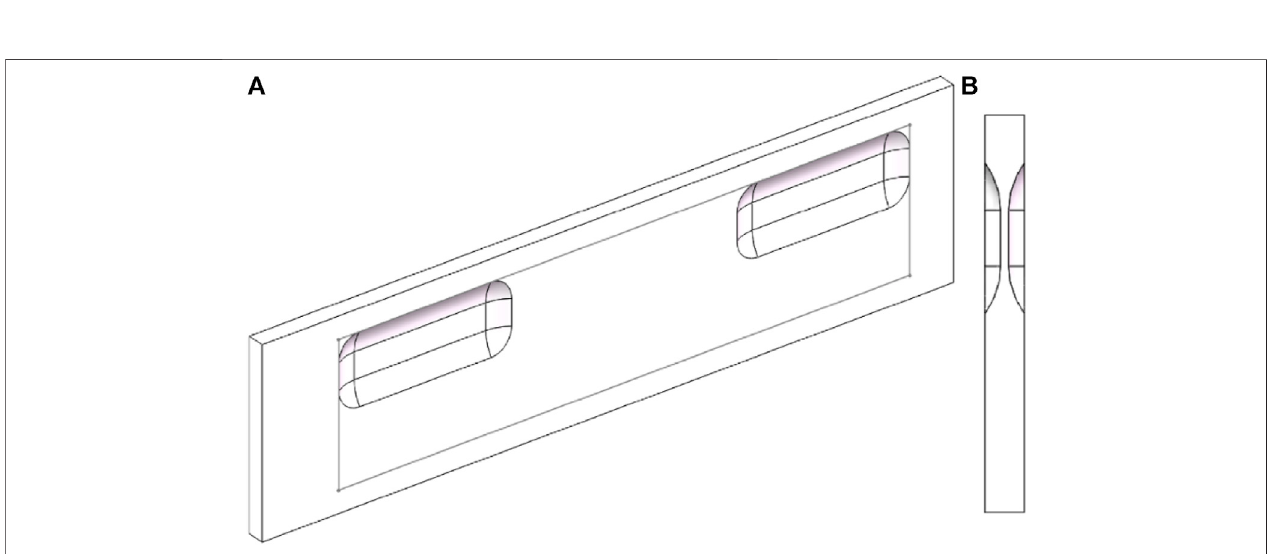
FIGURE 1 | The geometric model of round blisters in a single channel. (A) Partial magni fi cation (B) Global geometric (C) cross section.